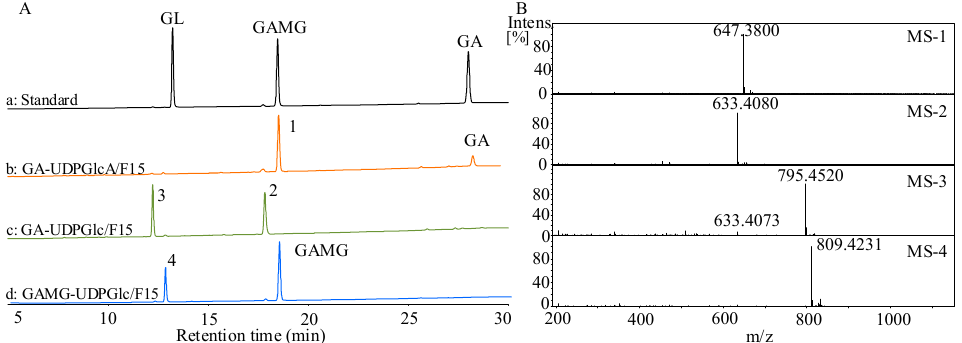
Figure 2. HPLC-MS analysis of the glycosylated products of GA and GAMG. ( A ) HPLC chromato- grams of GAMG standards (a), UGT73F15-catalyzed reaction using GA and UDP-GlcA as substrates (b), UGT73F15-catalyzed reaction using GA and UDP-Glc as substrates (c), and UGT73F15-cata- lyzed reaction using GAMG and UDP-Glc as substrates (d). ( B ) MS spectra for products 1–4.